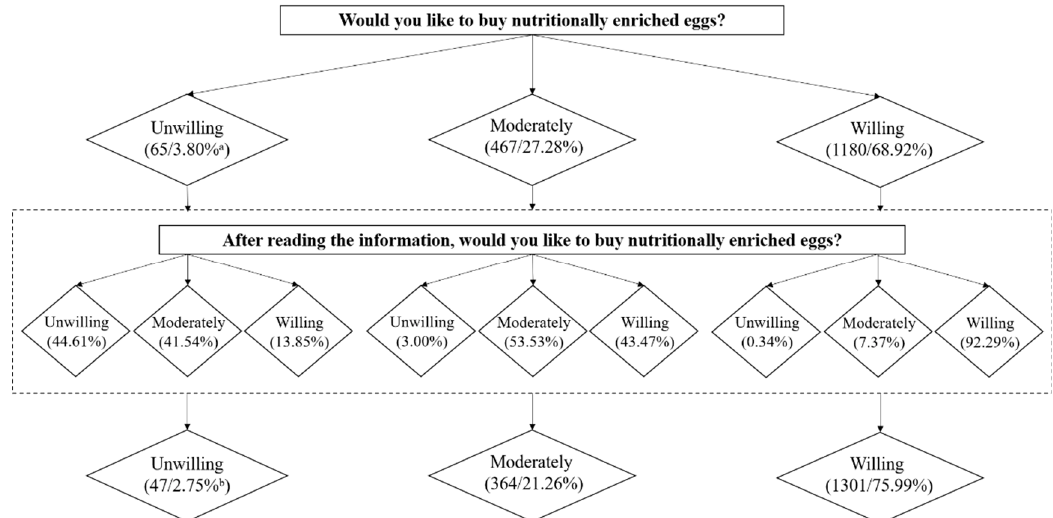
Figure 3. Respondents’ purchase intention before and after receiving the information. Note: a , b the proportion was calculated according to the total number of people in the treatment groups ( n = 1712). For example, 3.80% of participants, who were in treatment groups, were unwilling to try to purchase the nutritionally enriched eggs.